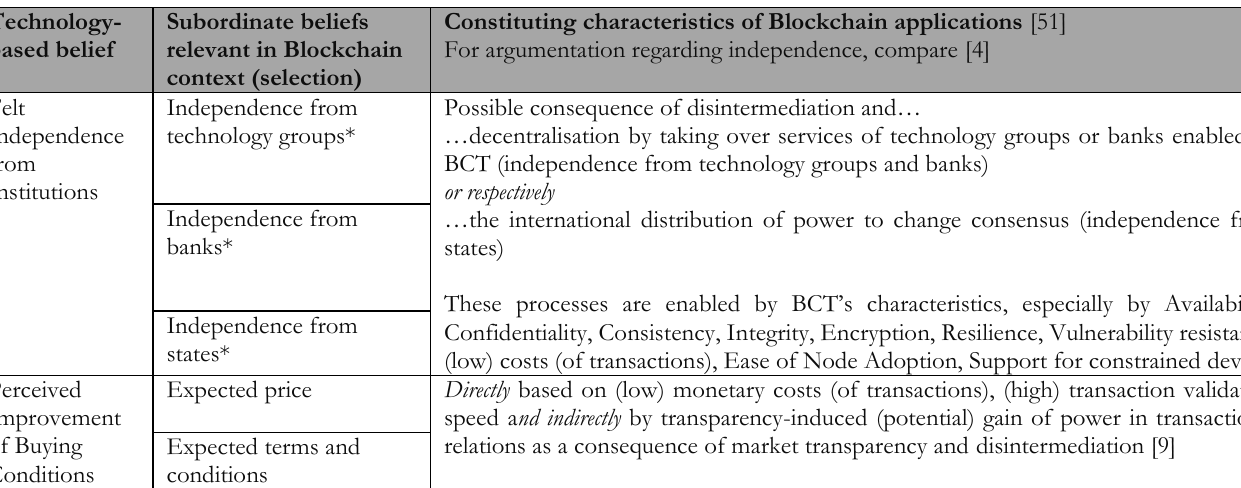
Table 2. Derivation of technology-based beliefs.